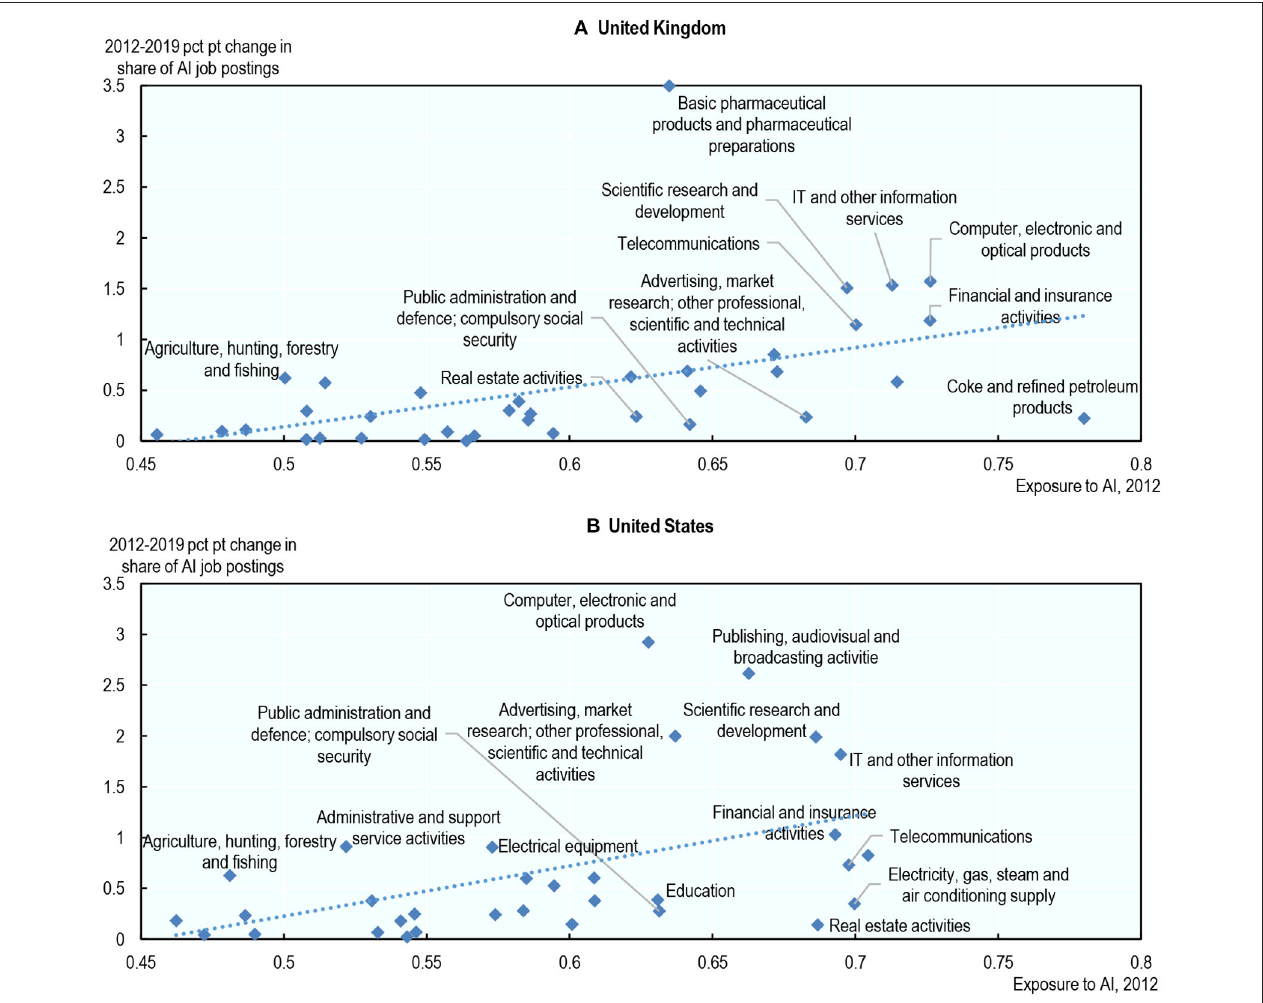
FIGURE 1 | Sectors with higher exposure to AI saw a higher increase in their share of job postings that require AI skills. Percentage point* change in the share of job postings that require AI skills (2012–2019) vs. average exposure to AI (2012), by sector. The share of job postings that require AI skills in a sector is the number of job postings requiring such skills in that sector divided by the total number of job postings in that same sector. Not all sectors have marker labels due to space constraints. *Percentage point changes are preferred over percentage changes because the share of job postings that require AI skills is equal to zero in some sectors in 2012. Source: Author’ calculations using data from Burning Glass Technologies, PIAAC and Felten et al. (2019). (A) United Kingdom and (B) United